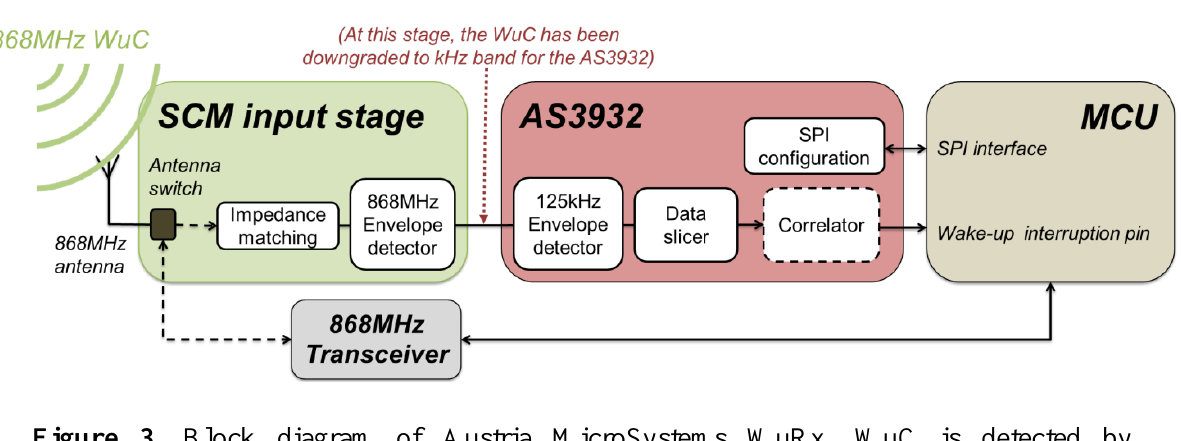
Figure 3. Block diagram of Austria MicroSystems WuRx. WuC is detected by magnetic